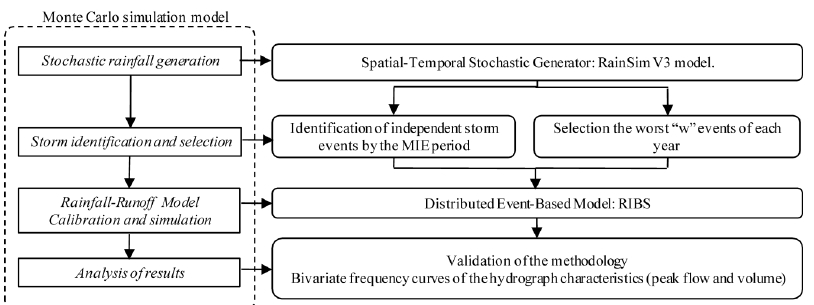
Figure 1. General conceptual framework of the MODEX methodology.